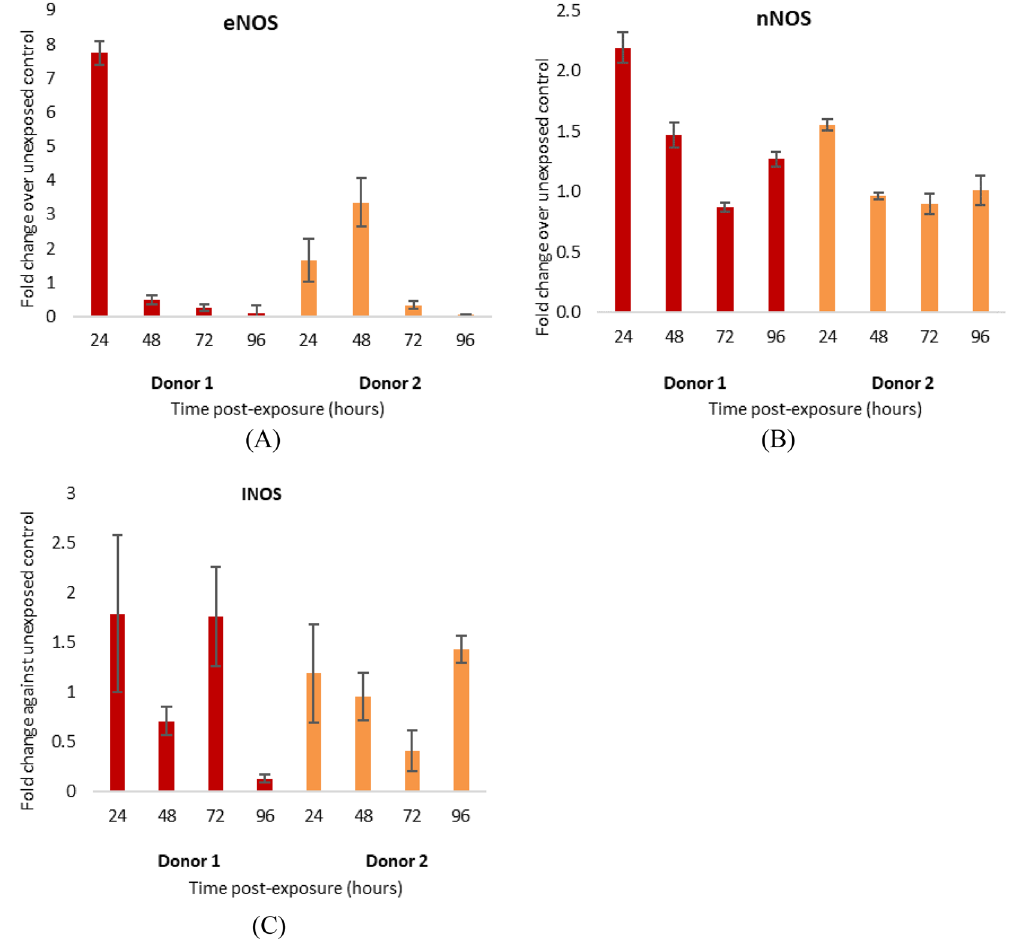
Figure 4. Fold change in eNOS ( A ), nNOS ( B ) and INOS ( C ) gene expression in primary human keratinocytes, up to 96 h after UV-A irradiation. Keratinocyte donor 1 in red and keratinocyte donor 2 in